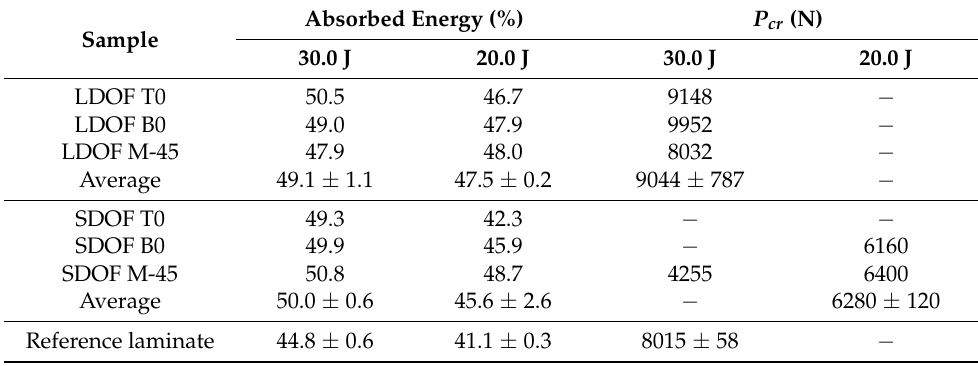
Table 4. Percentage of absorbed energy and critical load values measured on impacts with 20.0 and 30.0